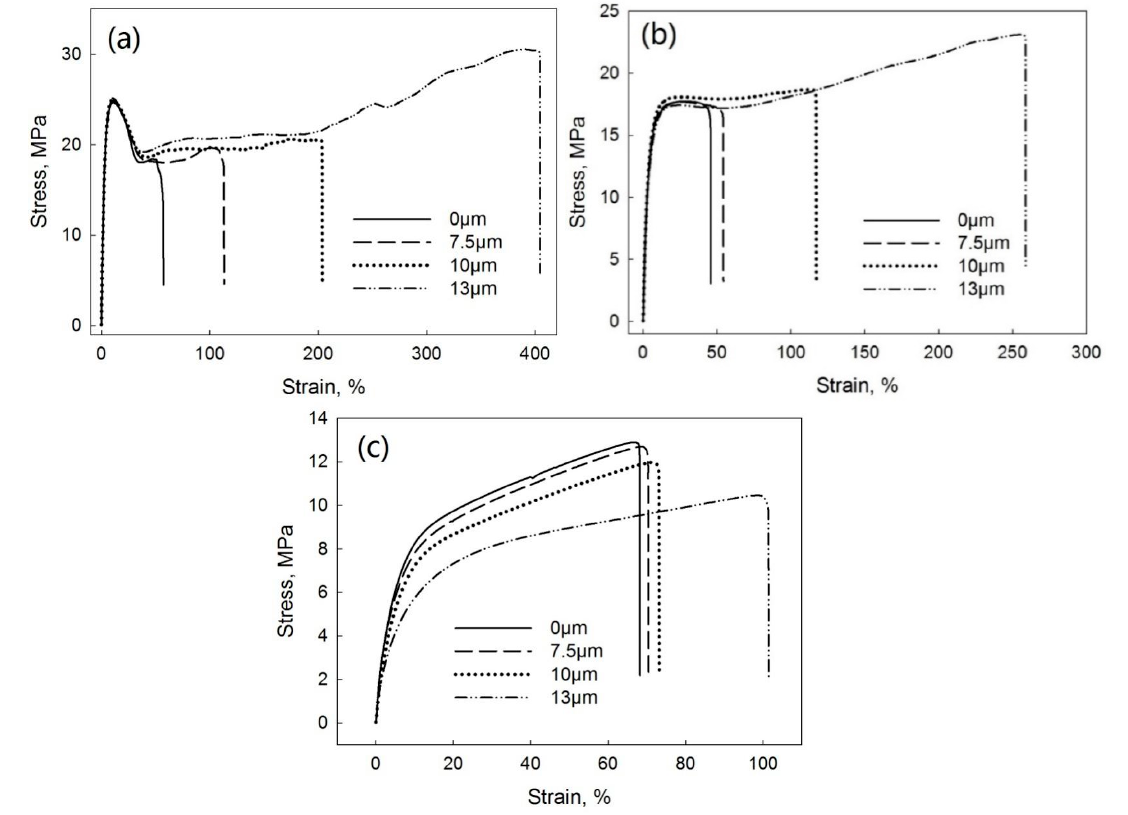
Figure 14. Stress–strain curves of PP/EPDM 75/25 ( a ), 50/50 ( b ), and 25/75 ( c ) blends prepared at different ultrasonic amplitudes by the DR method.